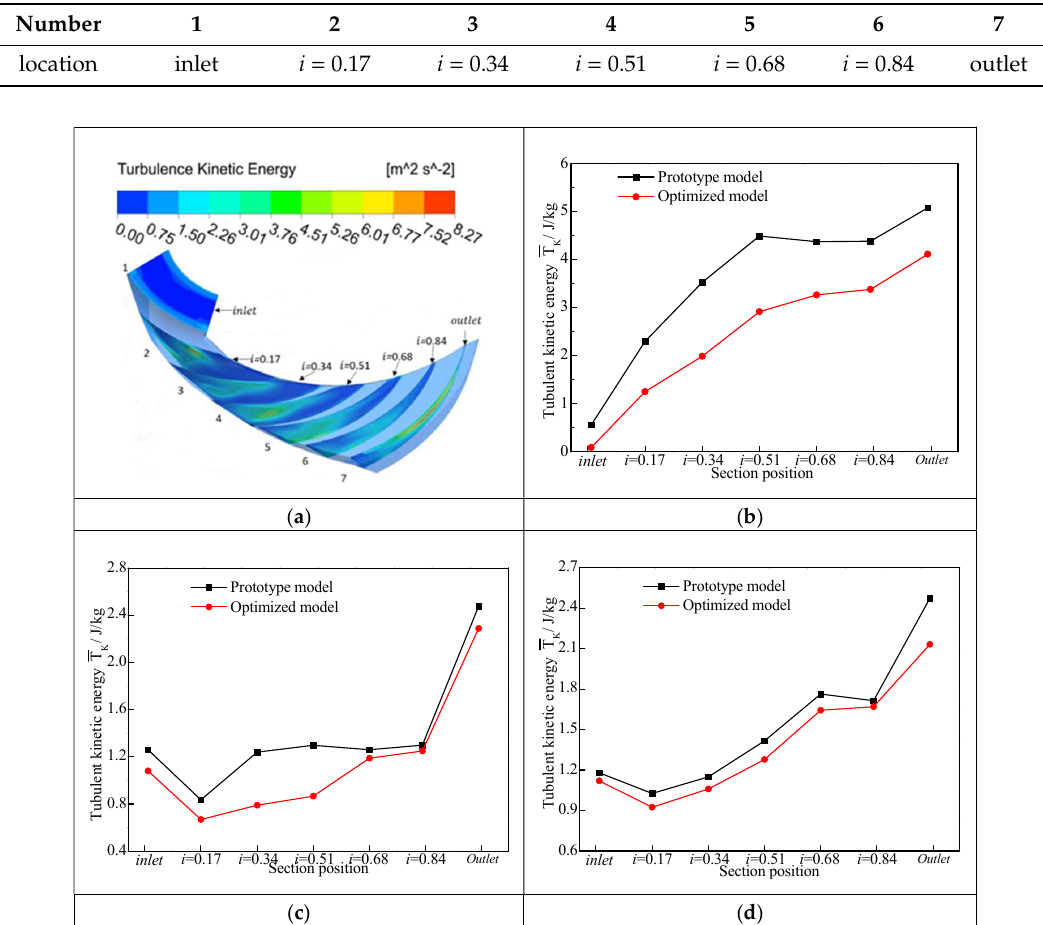
Table 2. Cross-section number and position relative value correspondence relationship.